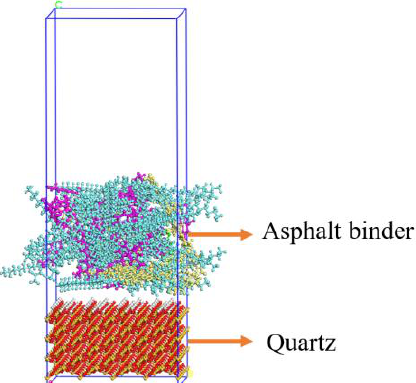
Figure 2. Double-layer interface model of SBS modified asphalt binder – aggregate.